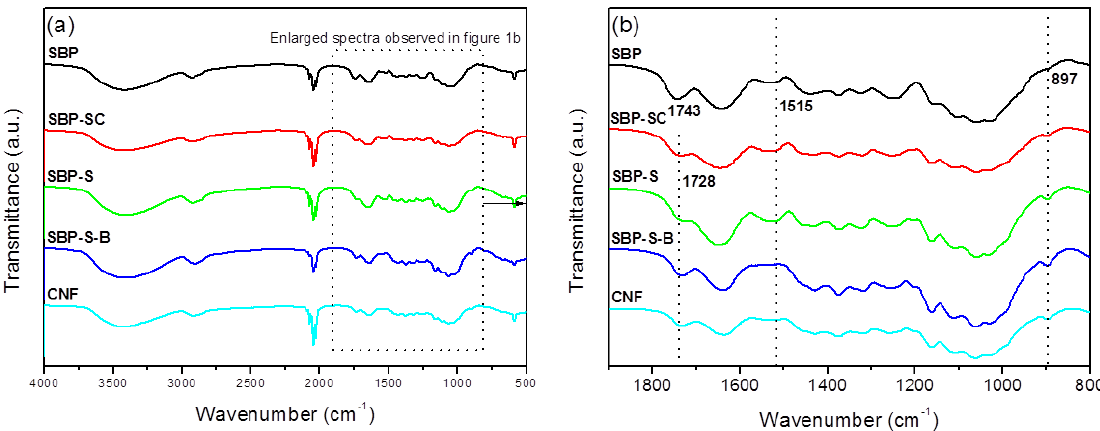
Figure 1. ( a ) Fourier transform – infrared (FT-IR) spectra of sugar beet pulp (SBP) samples SBP, SBP-S, SBP-S-B, and the CNFs; ( b ) enlarged FT-IR spectra between specific wavenumbers.